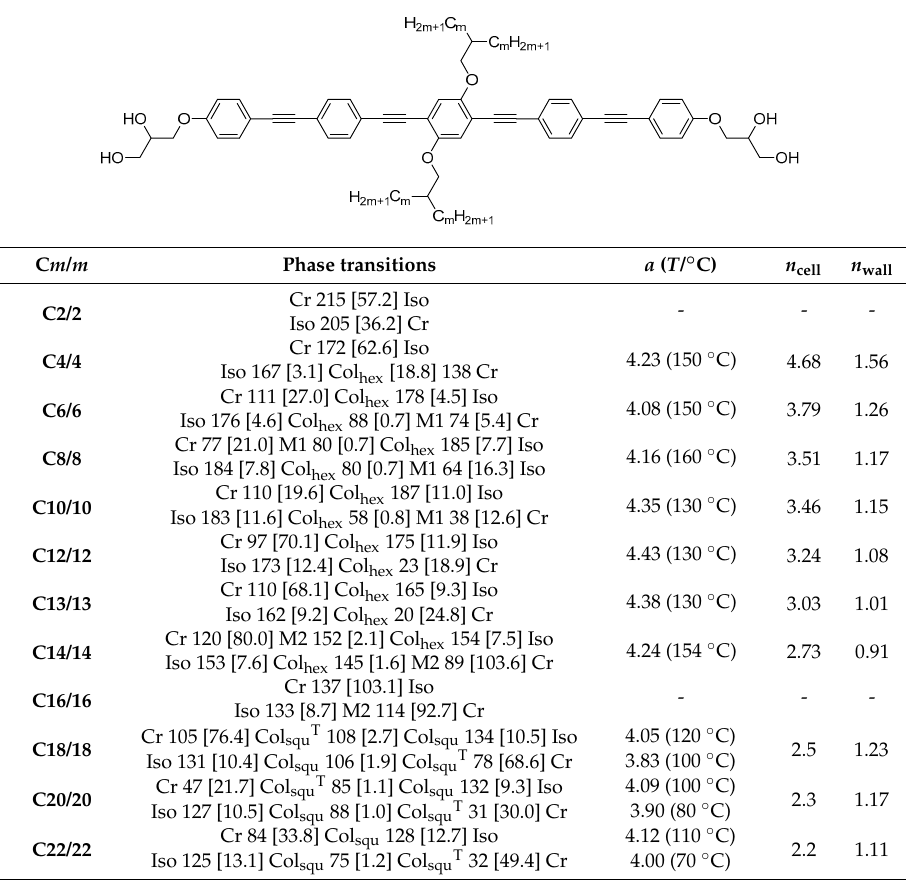
Table 1. Mesophase, phase transition temperatures ( T /°C) as observed on heating (top lines) and cooling (bottom lines), the corresponding enthalpy values ( Δ H /(kJ·mol − 1 ), in square brackets), and other data of compounds C m/m , depending on the length of the branches m a .